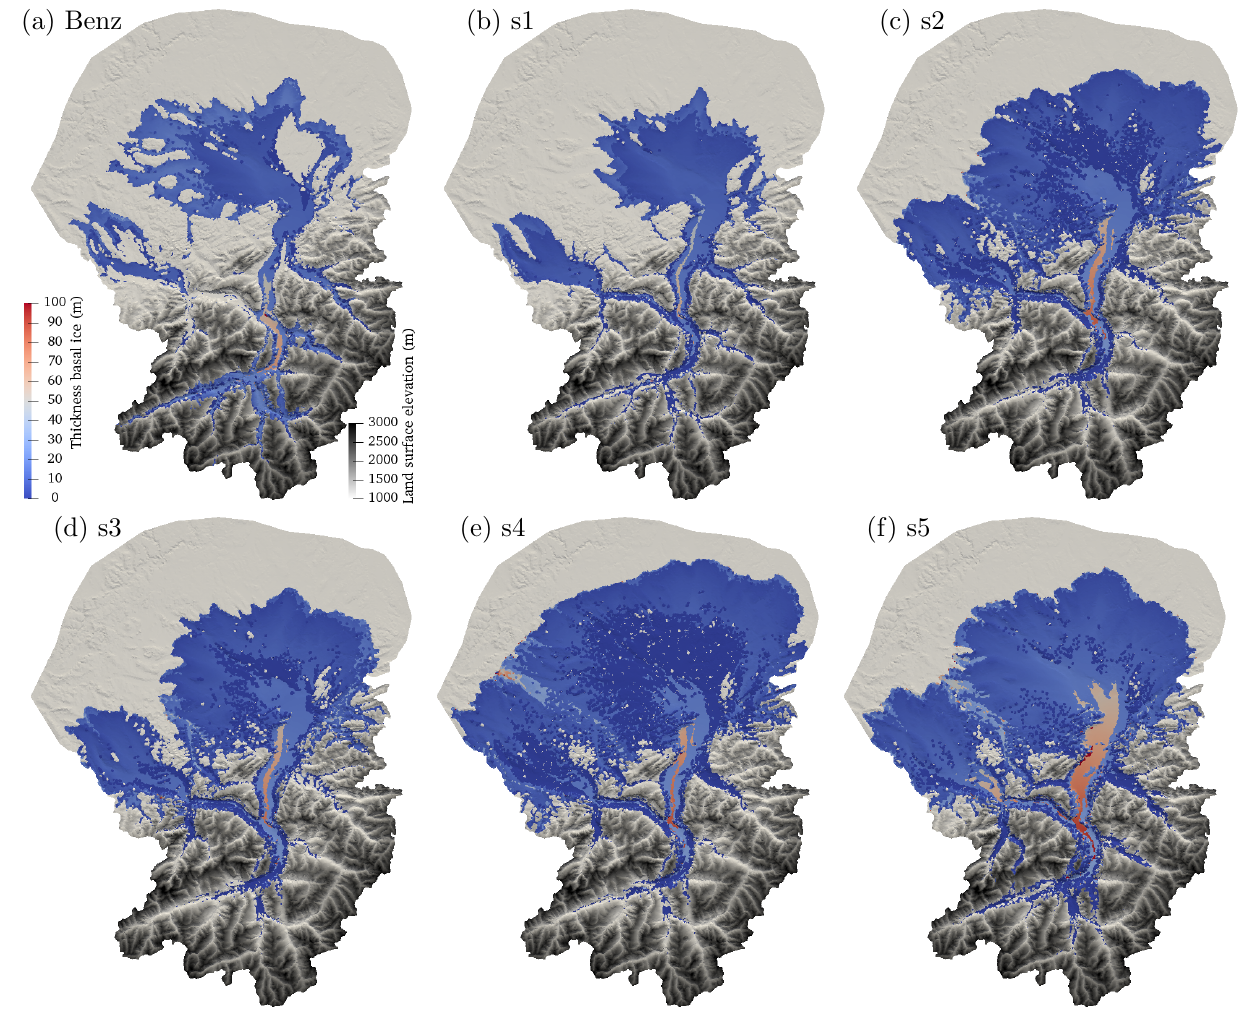
Figure 14. Extent and thickness in meters (blue to red color map) of temperate basal ice for (a) Benz-Meier (2003) after 50 years of free surface evolution and (b–f) simulations s1–s5. Background gray color scheme shows land surface